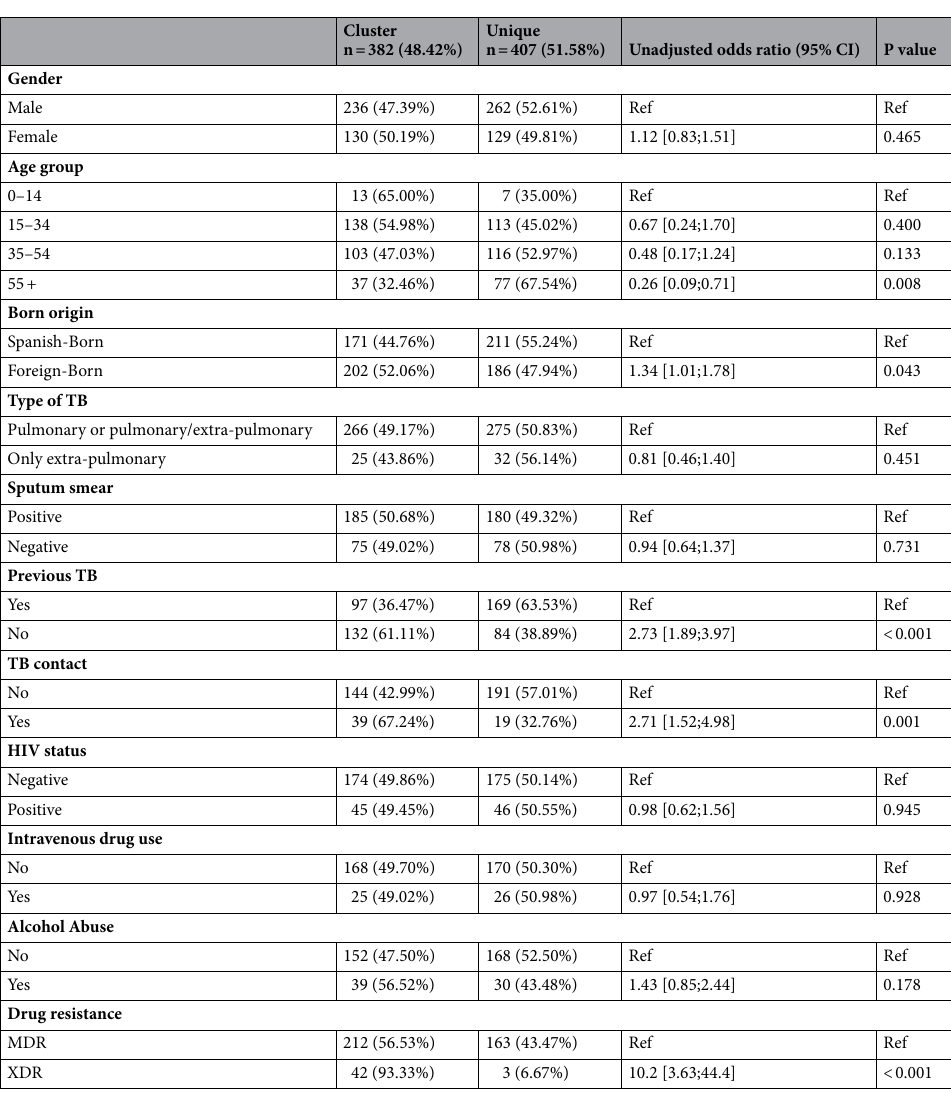
Table 1. Sociodemographic and clinical characteristic of cases according to clustered and non-clustered tuberculosis